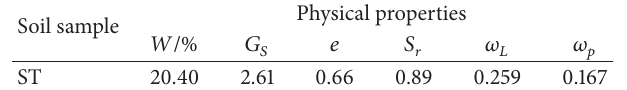
Table 1: Physical mechanical properties of tested soil. Physical properties Soil sample